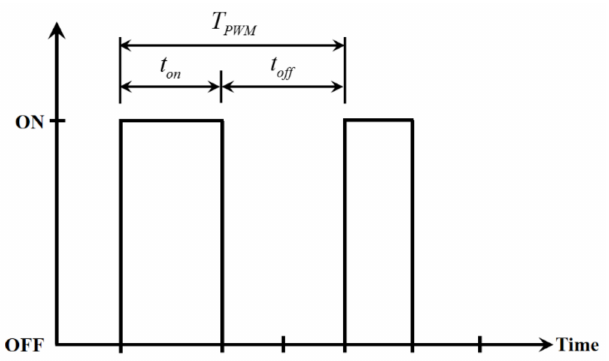
Figure 13. Schematic diagram of the interval type-2 fuzzy sliding pulse-width modulation